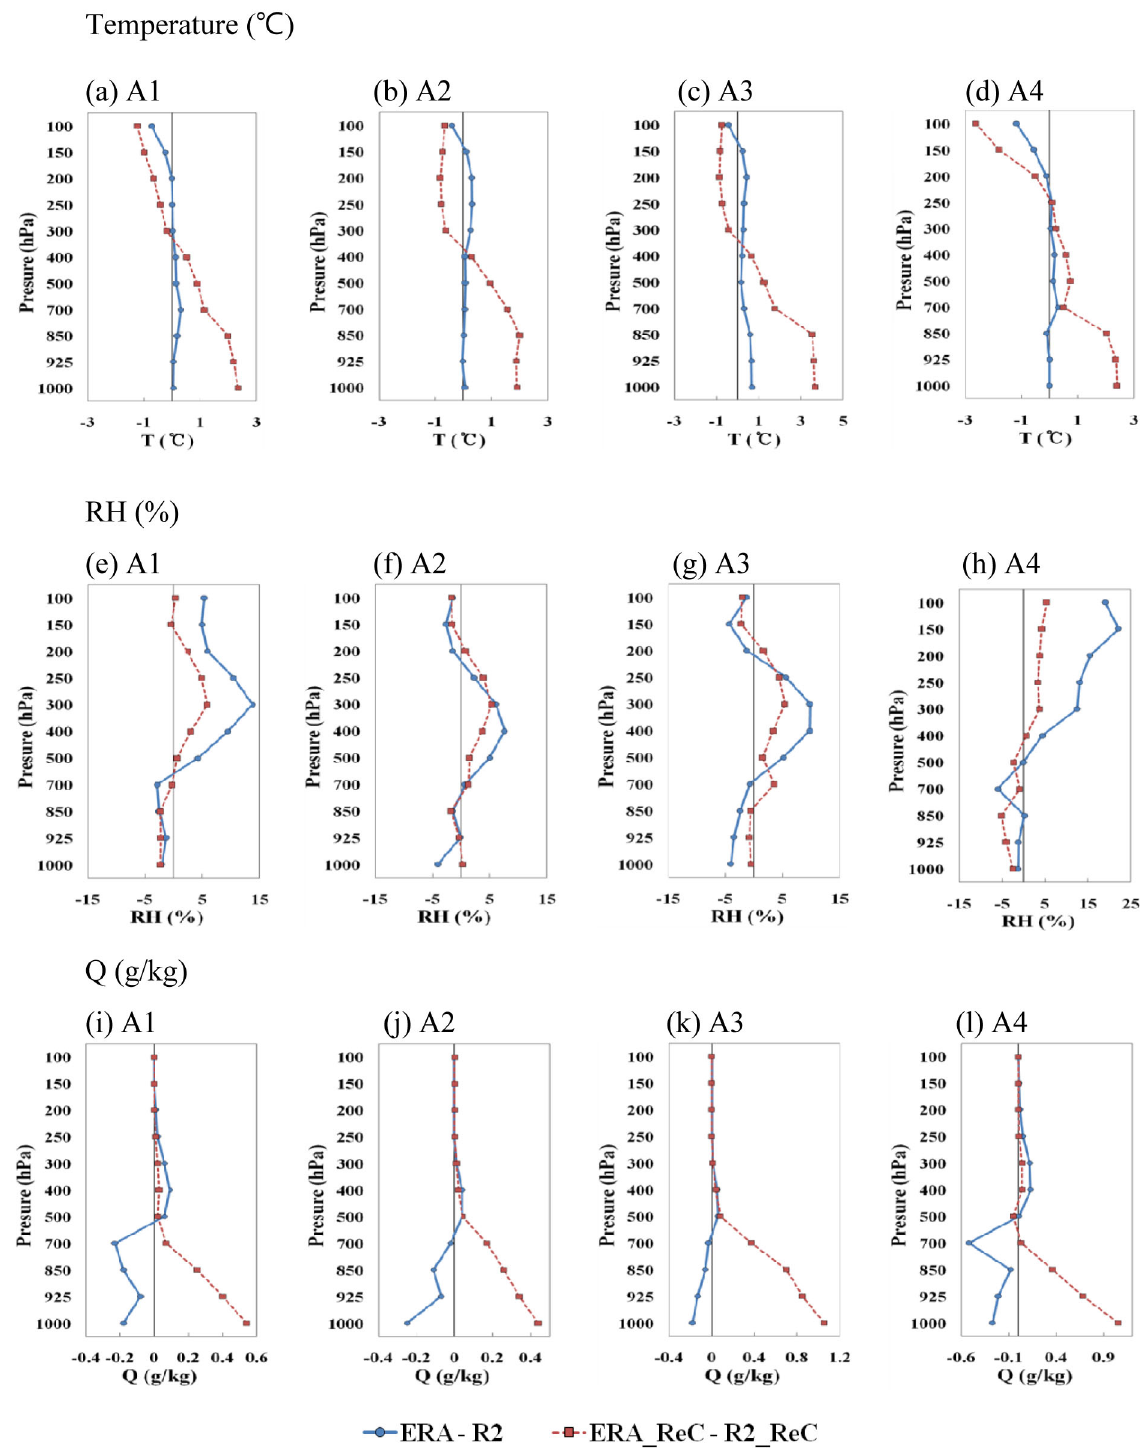
Figure 8. Vertical profiles of 20-year winter averaged differences between the ERA and R2 datasets ( blue ), and between the ERA_ReC and R2_ReC simulations ( red ) over the selected sub-areas (see Figure 1) for three selected climate elements (temperature ( a – d ), RH ( e – h ) and Q ( i – l